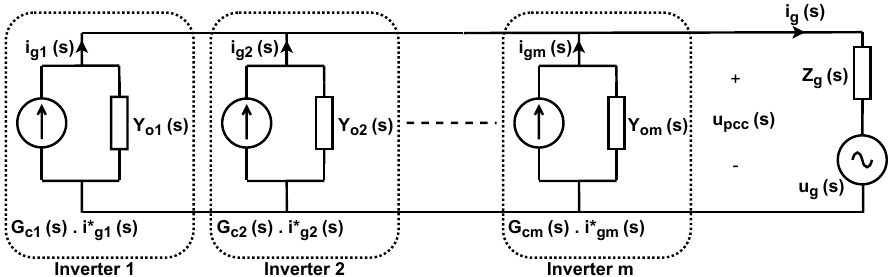
Figure 2. Equivalent admittance model of grid–connected multi–parallel inverters.